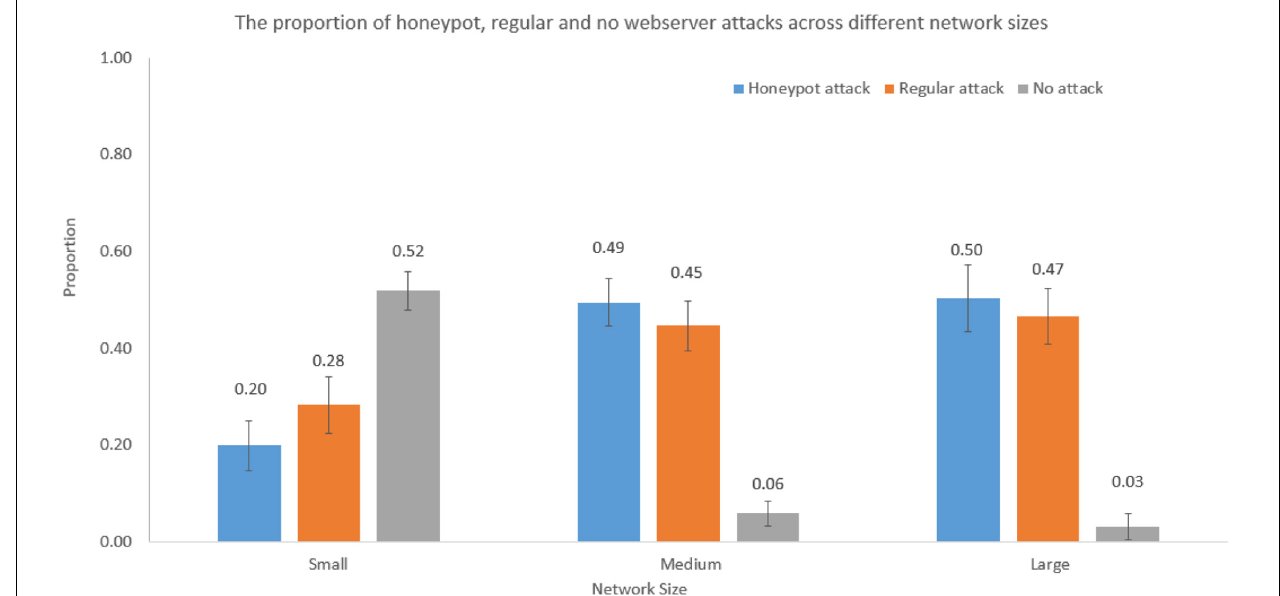
FIGURE 6 | The proportion of honeypot attack, regular attack, and no-attack decisions across different network